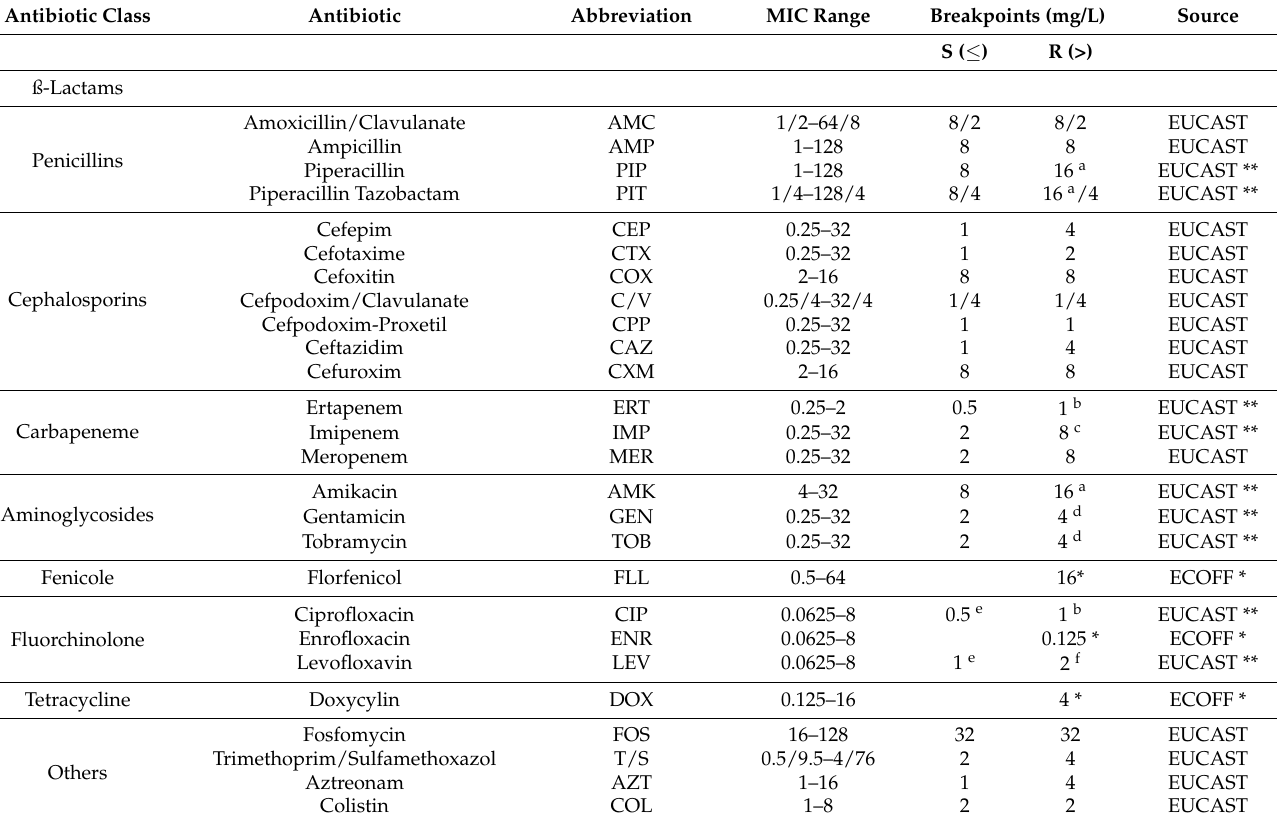
Table 2. Overview of antimicrobial agents used for phenotypic resistance